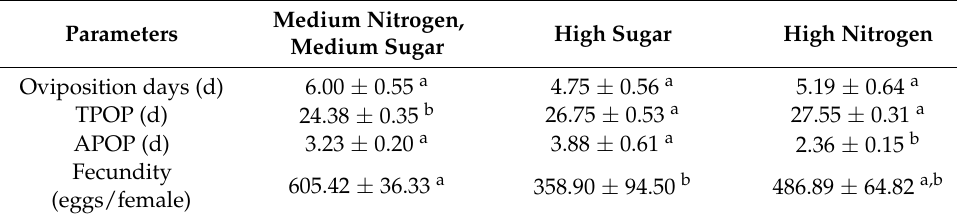
Table 2. Fecundity parameters of S. exigua under three nutritional